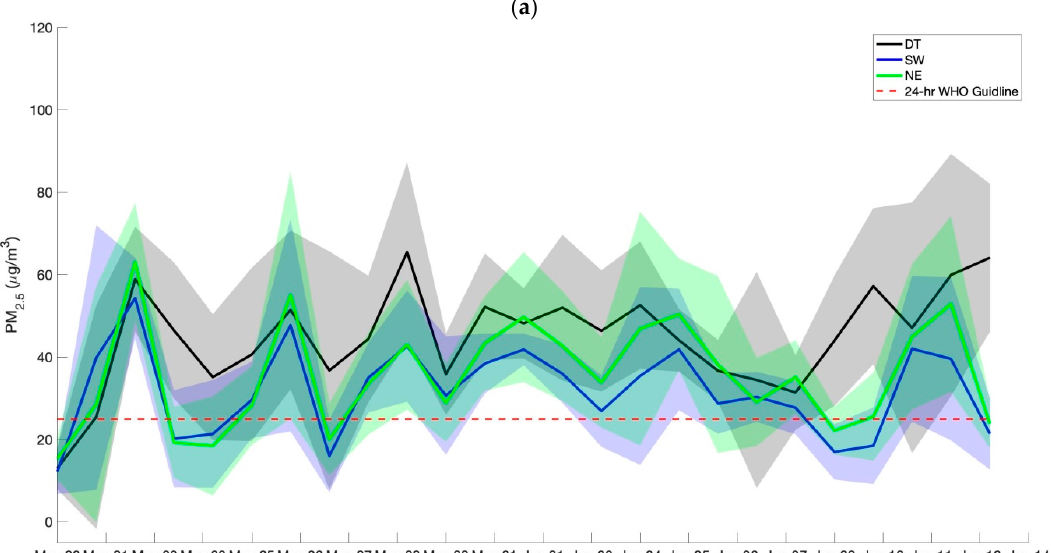
Figure 5. Daily average of concentrations of particulate matter less than 2.5 µm in aerodynamic diameter (PM 2.5 ) in the three locations—DT, SW, NE—compared to WHO guidelines ( a ) during the March–April period; ( b ) during the May–June period. (The shaded areas represent the standard deviations of the 1-min measurements in the 24 h period).